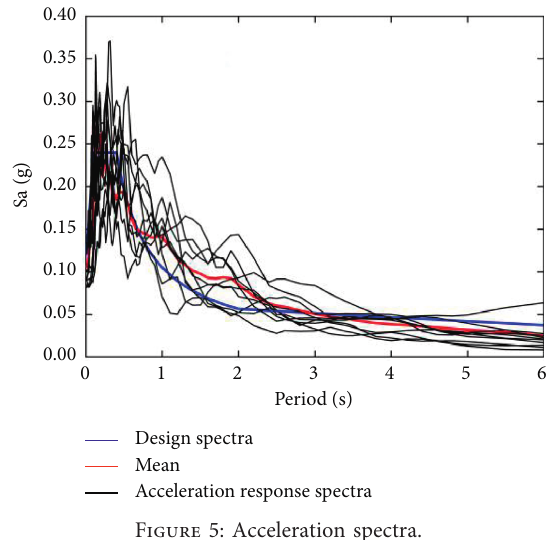
Figure 5: Acceleration